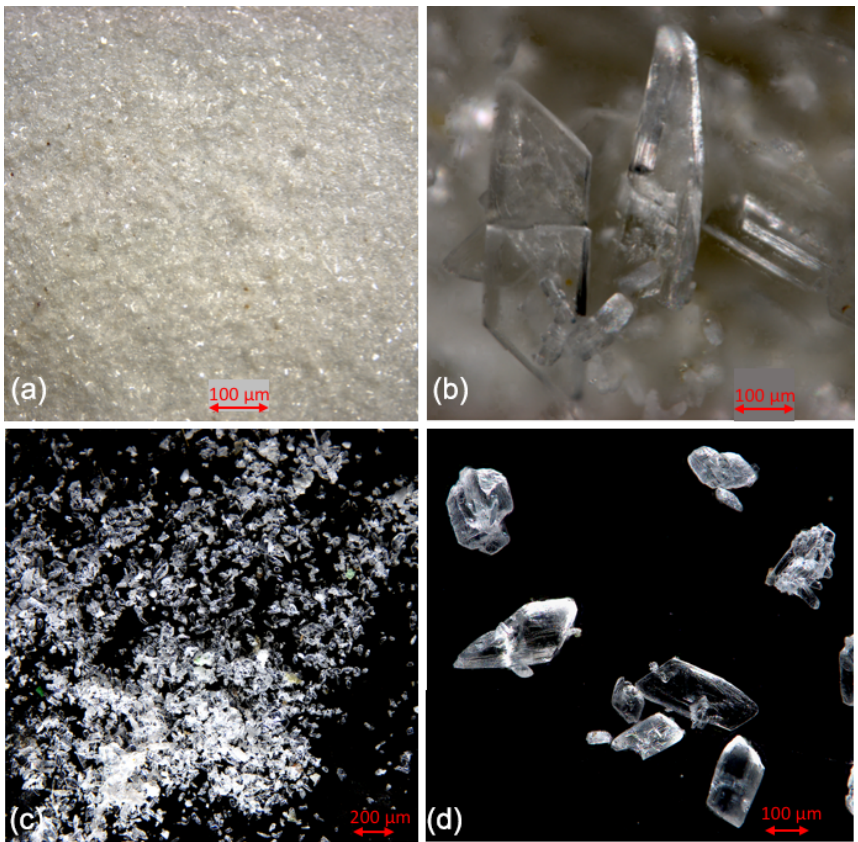
Figure 4. Comparison of cryogenic gypsum crystals collected from the water column at station PS45 (10m water depth) (a, b) with crystals retrieved from an ice core collected above the ROVnet sampling area (c, d) . Table 3. Dissolution experiments on cryogenic gypsum crystals. “Water mass” simulating experiments with 34.9‰ sterile filtered seawater. Each experiment was conducted in parallel in 3–4 separate pressure